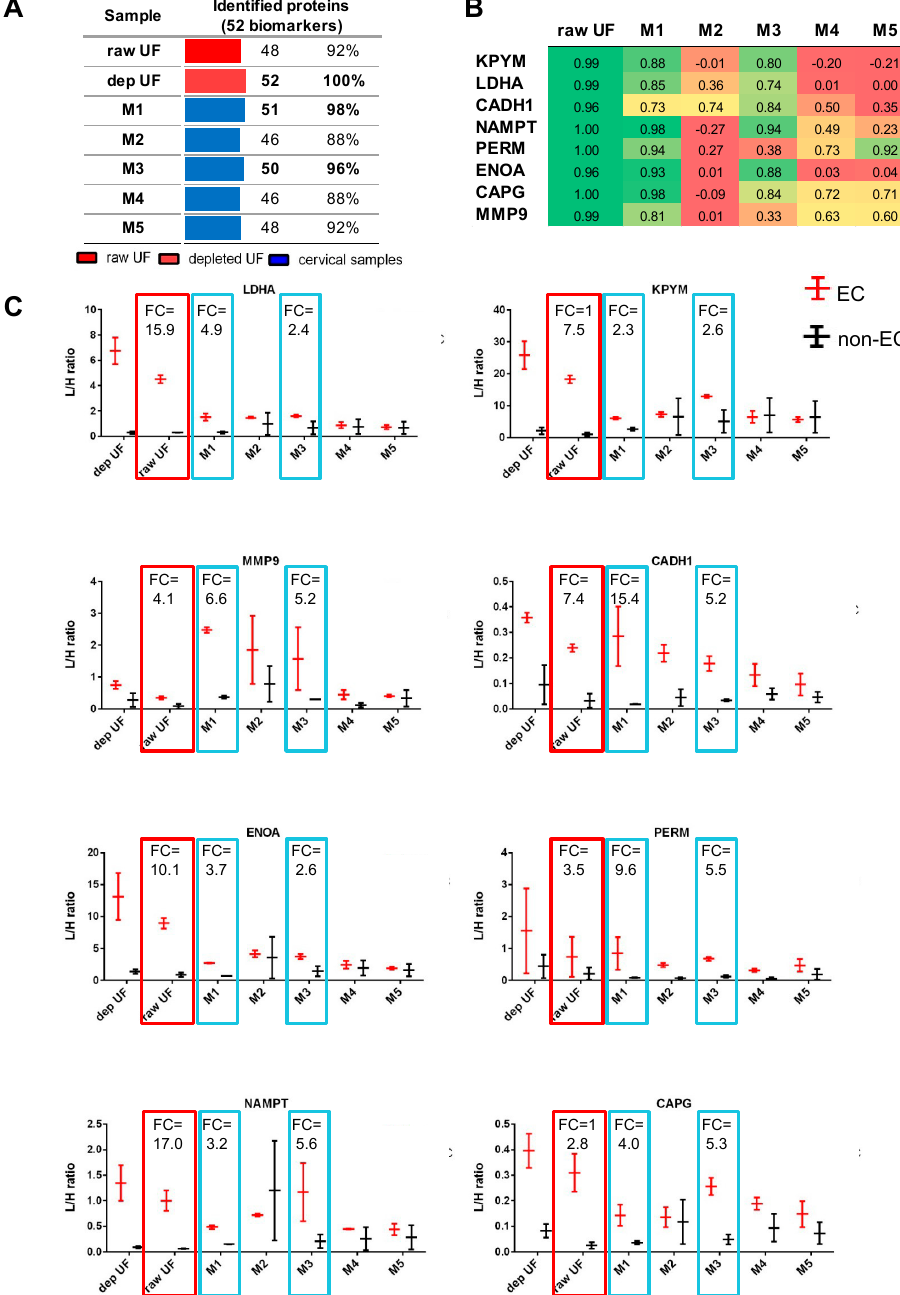
Figure 3. Quantification of 52 EC diagnostic biomarkers in 7 different matrices from 4 patients. ( A ): Bar plots representing the number of proteins out of the 52 EC biomarkers identified in each matrix (in red uterine fluids, and in blue cervical fluids). ( B ): Pearson correlation coefficients showing the degree of correlation between the levels of the 8 best performing EC biomarkers across the 4 patients when measured in the depleted uterine fluid versus each of the other matrices analyzed. ( C ): Dot plots representing the levels (L/H ratios) of the 8 EC protein biomarkers in the different matrices of the EC (in red) and non-EC (in black) patients. The highest fold changes between EC and non-EC patients are observed in the uterine fluids (red square), and M1 and M3 cervical samples (blue squares) for all the 8 proteins. L/H ratio: light/heavy ratios; FC: fold change.